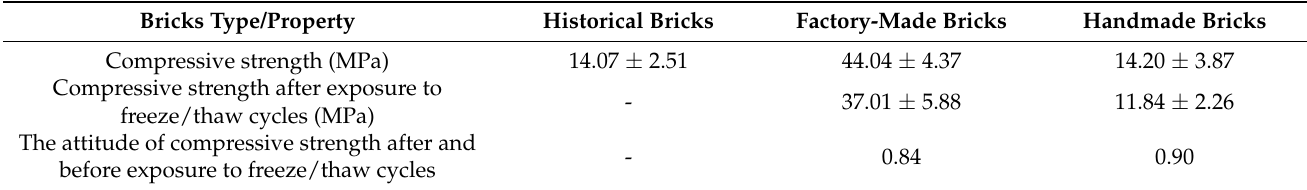
Table 2. Compressive strength of bricks before and after freezing with the corresponding standard deviation and the ratio of compressive strengths pre- to post-freezing.